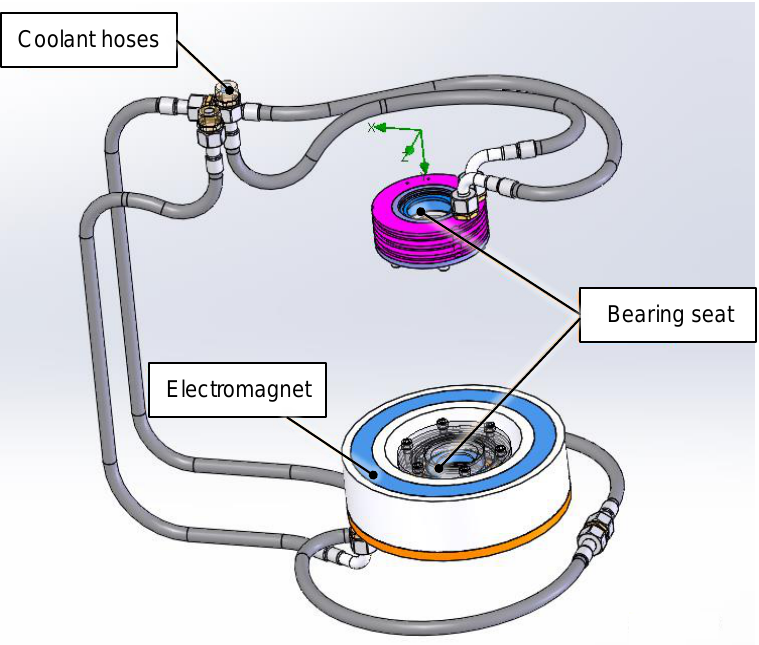
Figure 20. Basic hydraulic scheme for CFD simulation of the bearing system and the electric magnet. (Setup flipped upside down with lifting magnet shown at the bottom).